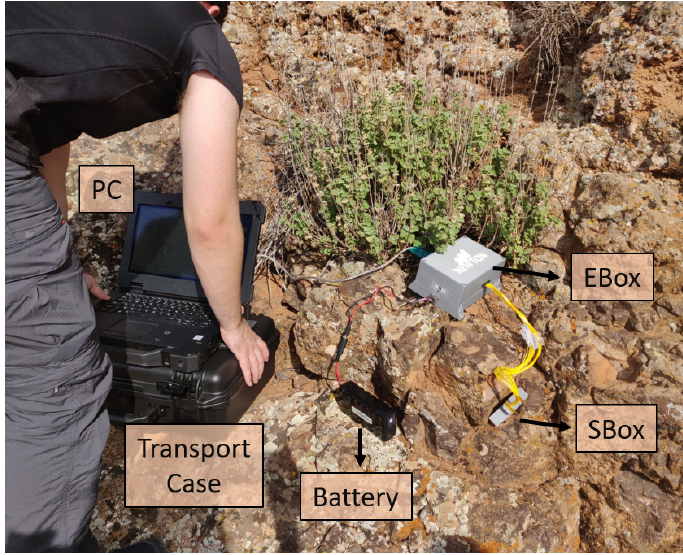
Figure 5. NEWTON instrument: S-box with the sensing head and E-box with control electronics. Auxiliary devices such as a PC, battery, and a transport case. Auxiliary devices such as a PC, battery, and a transport